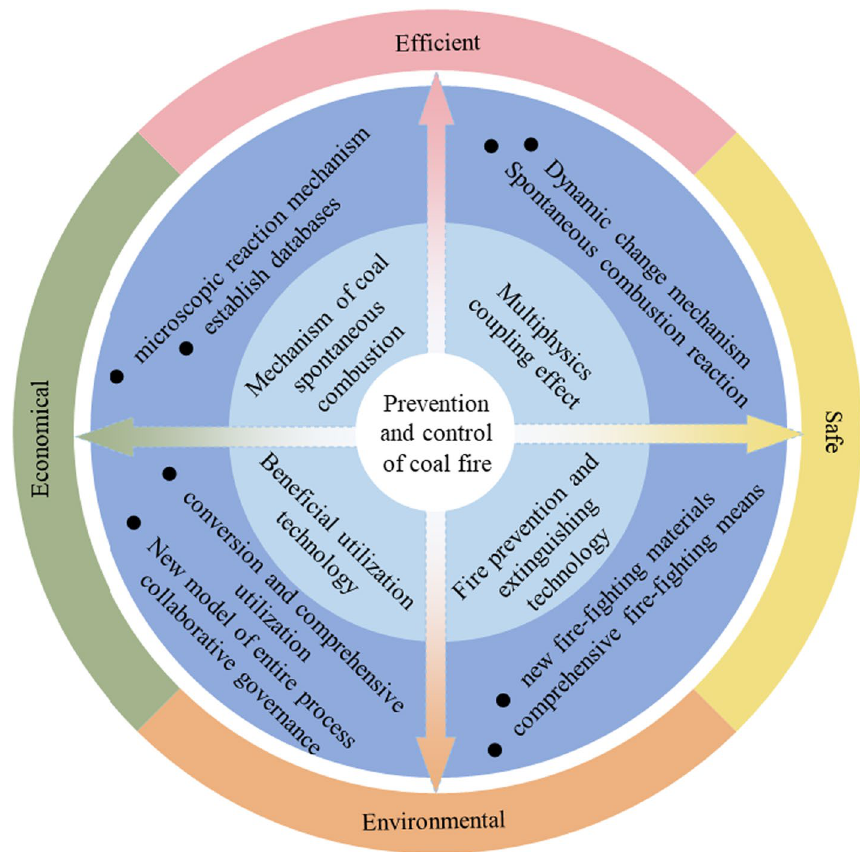
Fig. 12 Prospects for the pre- vention and control of coal fire